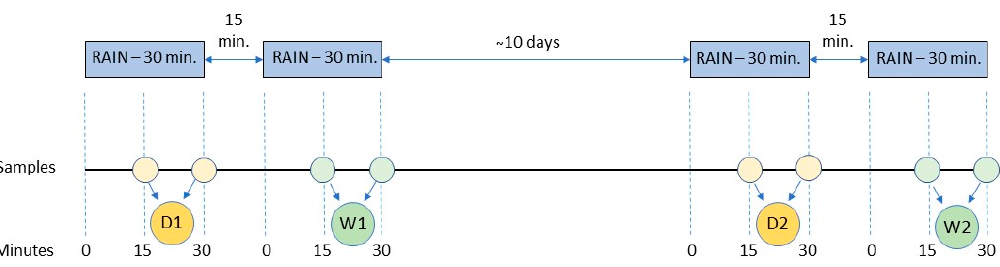
Figure 2. Scheme of the sampling procedure at the experimental